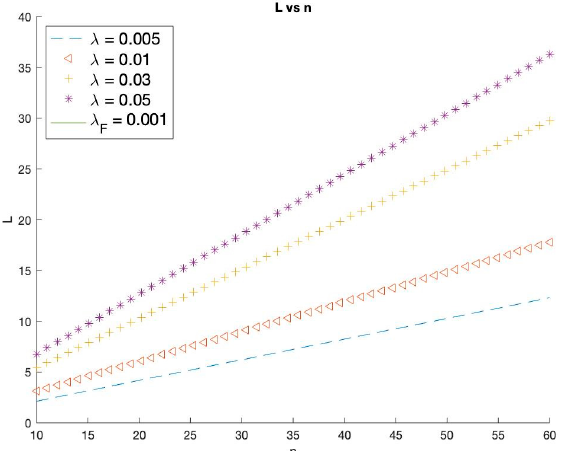
Figure 1. Average number of customers in system ( L ) vs number of slots ( n ).